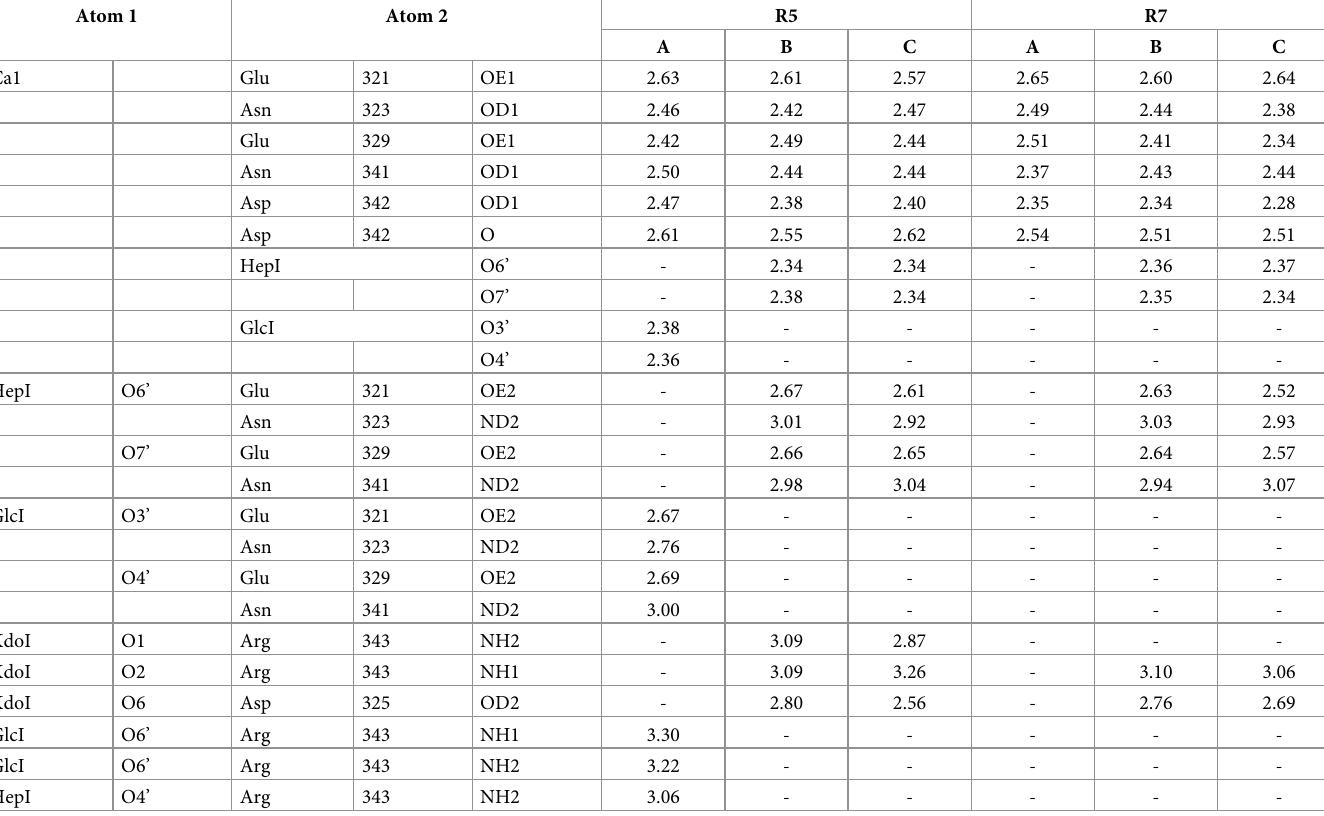
Table 2. Calcium and ligand binding distances (Å). Atom 1